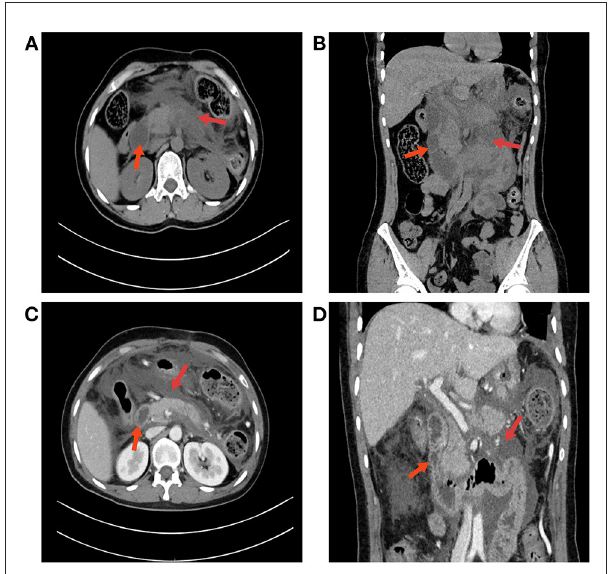
FIGURE1 An abdominal CT scan confirmed the diagnosis of acute pancreatitis. (A) Abdominal CT revealed fluid collection around the pancreas; red arrows indicate an undilated duodenum and a large amount of exudate. (B) CT coronal imaging. (C) Contrast-enhanced abdominal CT. The arrow on the left indicates the duodenum, and the arrow on the right indicates a necrotic lesion of the pancreas with a large amount of local exudate. (D) No obstruction was found in the duodenum on abdominal CT.